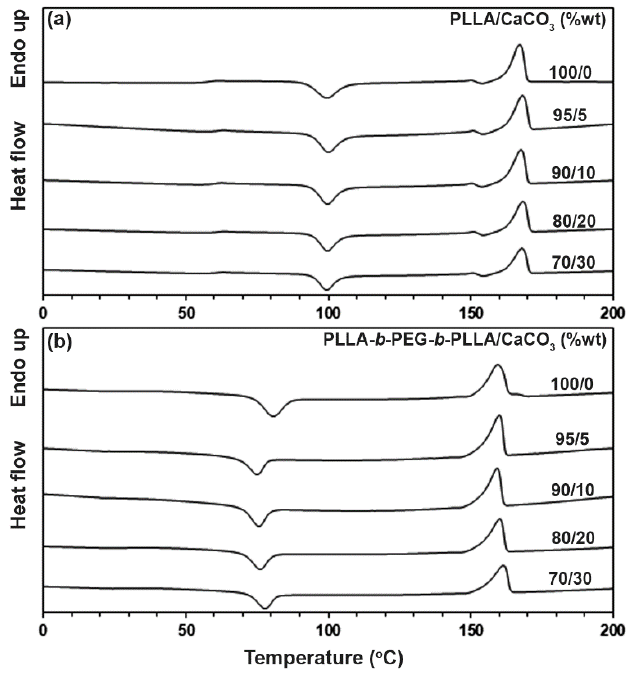
Figure 3. DSC heating curves of ( a ) PLLA/CaCO 3 and ( b ) PLLA- b -PEG- b -PLLA/CaCO 3 composites with various CaCO 3